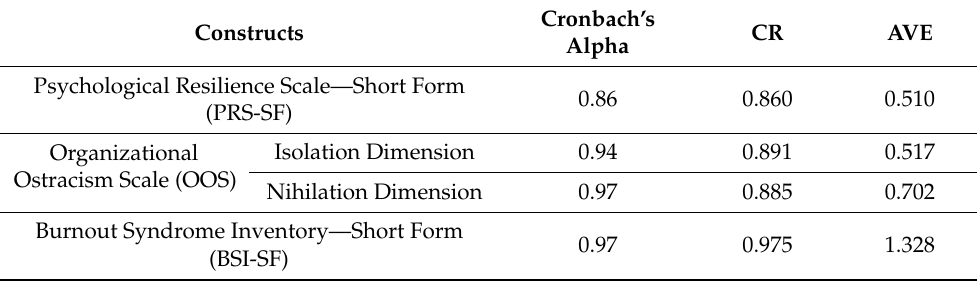
Table 6. Cronbach’s Alpha, CR, and AVE scores of the scales.